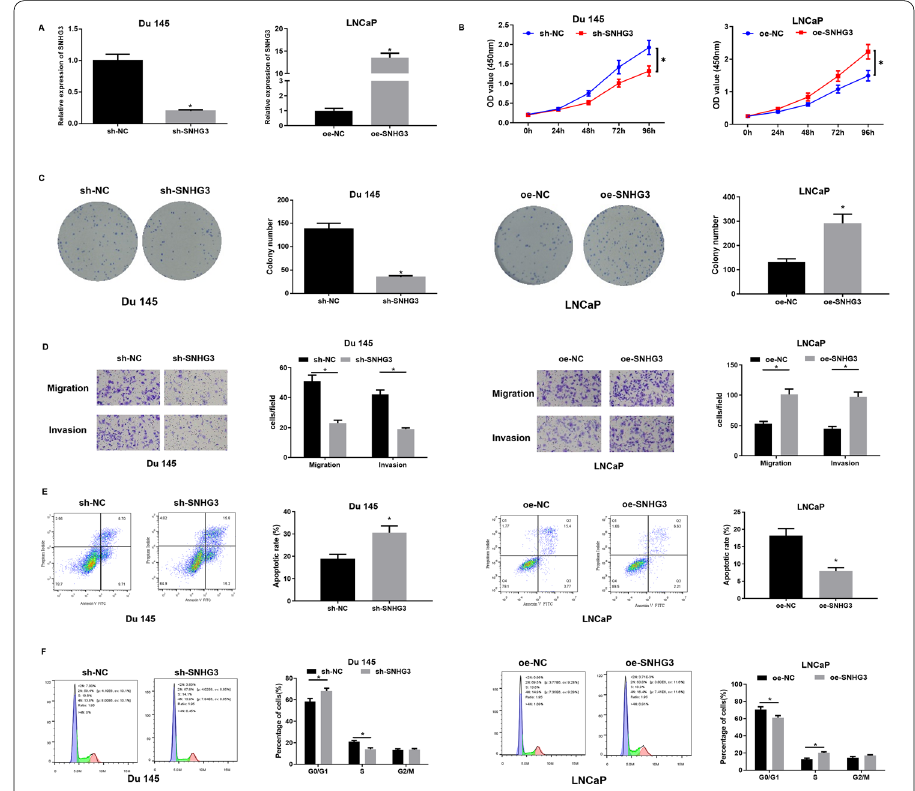
Fig. 2 SNHG3 knockdown hampers proliferation, migration, and invasion, and stimulates apoptosis of PCa cells. A qRT-PCR assessed SNHG3 expression in PCa cells), * p < 0.05; B CCK-8 assay determined proliferation of PCa cells, * p < 0.05; C Colony formation assay measured colony formation in PCa cells, * p < 0.05; D Transwell assessed migration and invasion of PCa cells, * p < 0.05; E , F flow cytometry detected apoptosis and cell cycle distribution of cells transfected with sh-SNHG3. All the experiments were repeated 3 times, * p <